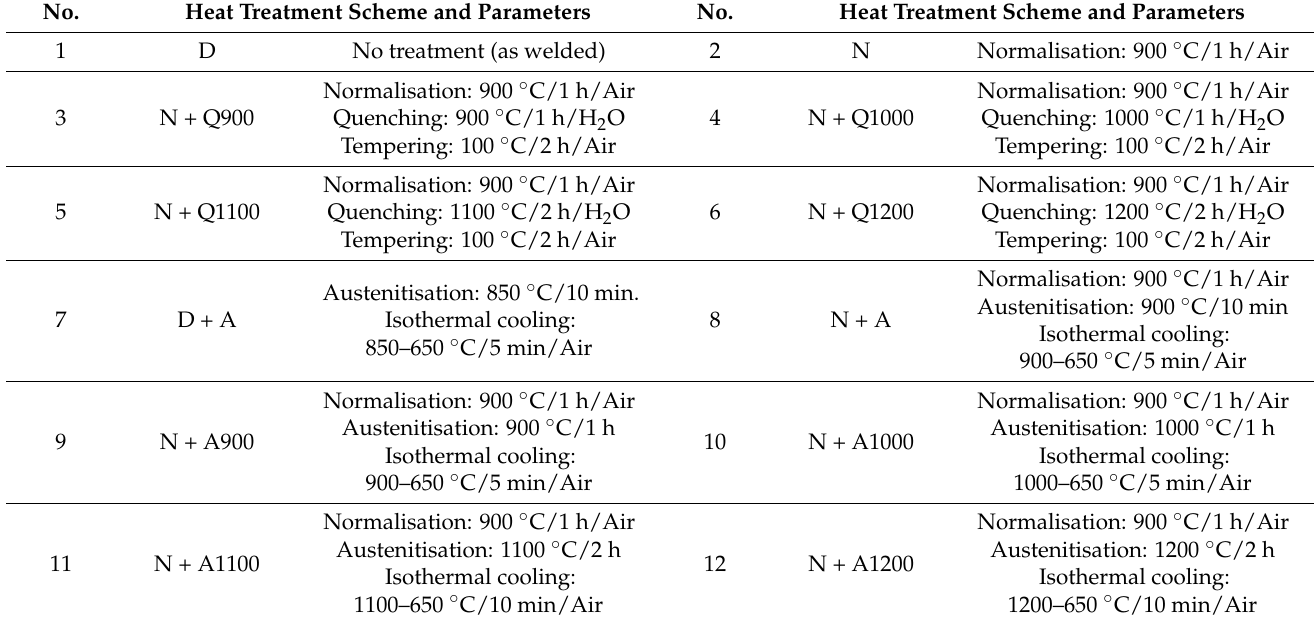
Table 5. The framework and detailed parameters of heat treatment carried out for welded joints of Hardox 450 steels. No.1– 6—samples subjected to strength and impact tests, No.7–12—samples subjected to grain growth analysis of prior austenite.